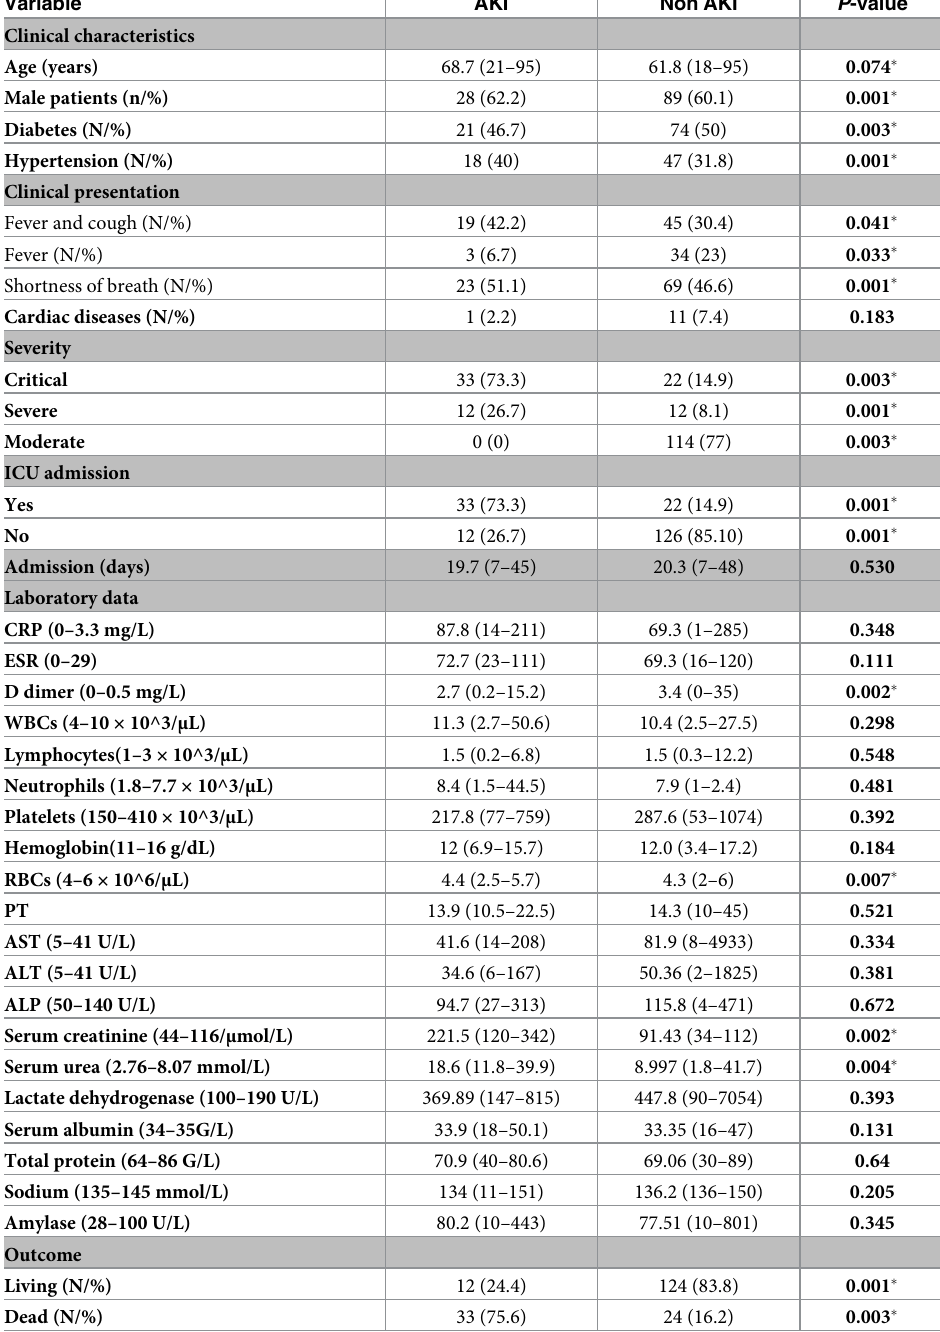
Table 3. Clinical and laboratory data in relation to AKI in patients with COVID-19.